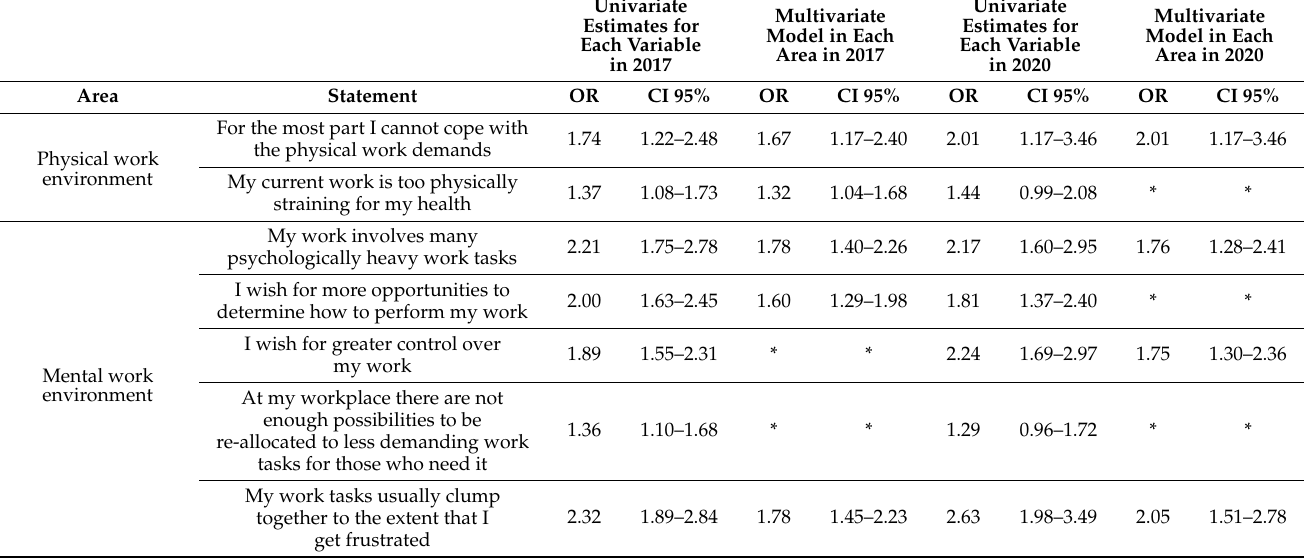
Table 2. Univariate and multivariate variables 2017 and 2020. Univariate estimates and multivariate models in each of the analyzed areas between the statements (agree vs. disagree) and work-related mental health diagnoses and other factors. OR = Odds ratio; CI = Confidence interval. * The variable shows no statistical significance in the multivariate modelling and is, therefore, not included in the final multivariate model shown in this